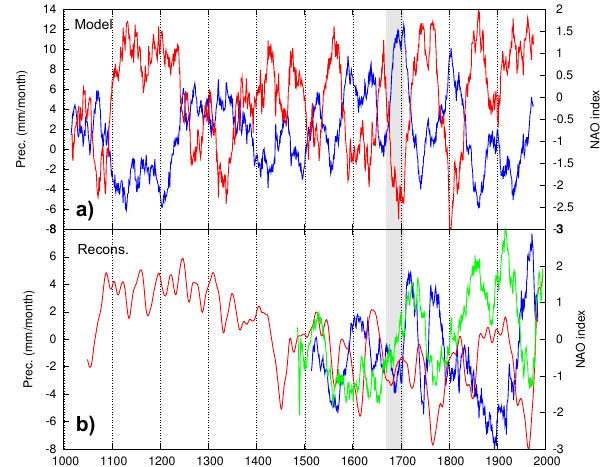
Fig. 16. (a) NAO index (red line) and precipitation (blue line) as simulated by ECHO-G+MM5 during the last millennium. (b) NAO Fig. 16. a) NAO index (red line) and precipitation (blue line) as index as reconstructed by Luterbacher et al. (2002) (green line), by simulated by ECHO-G+MM5 during the last millennium. b) NAO Trouet et al. (2009) (red line), and Pauling et al. (2006) precipita- index as reconstructed by Luterbacher et al. (2002) (green line), by tion series (blue line). All anomalies are calculated with respect to the period 1900–1990 and averaged for the IP. Green line has been Trouet et al. (2009) (red line), and Pauling et al. (2006) precipitation smoothed through a low-pass filter, likewise the rest of the series series (blue line). All anomalies are calculated respect to the period have been smoothed through a running mean of 31 years. Grey bar 1900-1990 and averaged for the IP. Green line has been smoothed indicates the Maunder Minimum period discussed in the through a low-pass filter, meanwhile the rest of the series have been smoothed through a running mean of 31 years. Grey bar indicates the Maunder Minimum period discussed in the text.